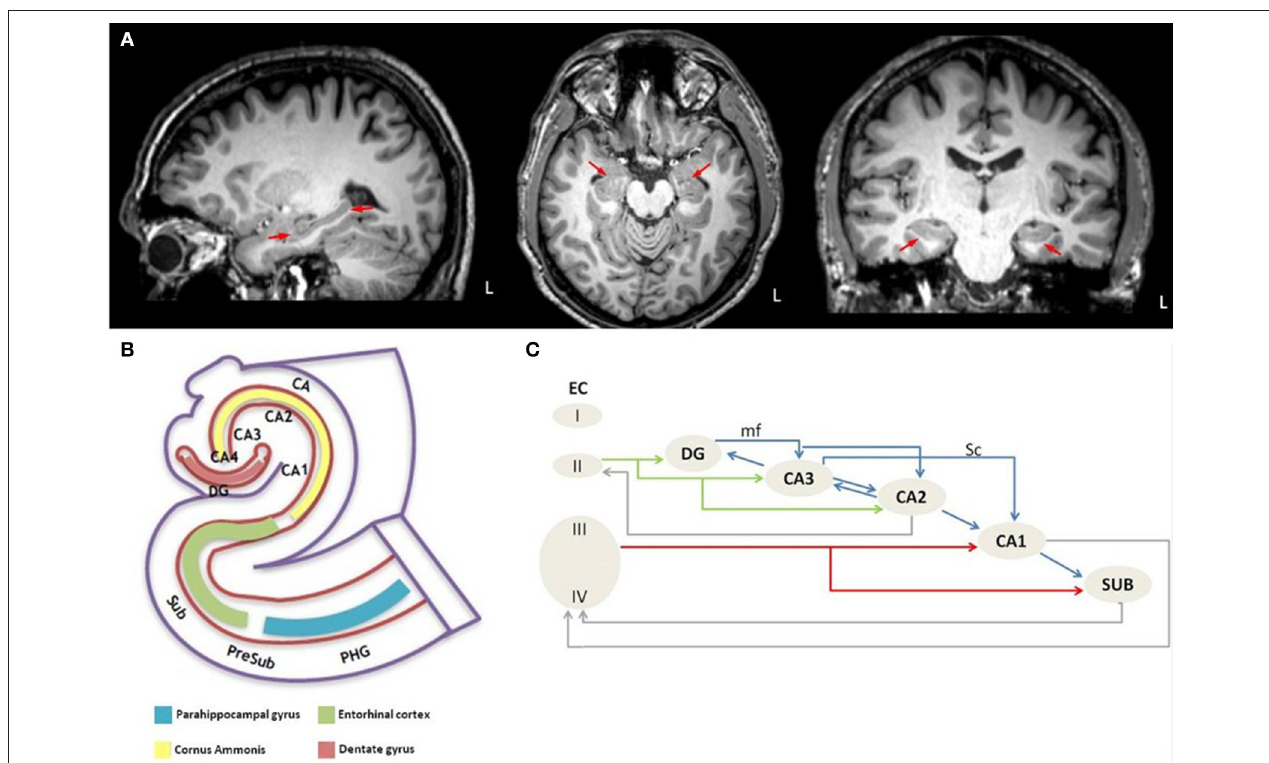
FIGURE 1 | Anatomical depiction of hippocampus on sagittal, axial and coronal plane of high resolution T1 image from a healthy control subject (A) and schematic representation of (B) the anatomy of the hippocampus-entorhinal cortex-parahippocampal gyrus system and (C) the intrahippocampal connections. L, left hemisphere; PHG, parahippocampal gyrus; PreSub, Presubiculum; Sub, Subiculum; CA, Cornu Ammonis; CA1-CA4, Cornu Ammonis subfields; DG, Dentate gyrus; EC, Entorhinal cortex; I-IV, Layer I-IV; mf, mossy fibers; Sc, Schaffer